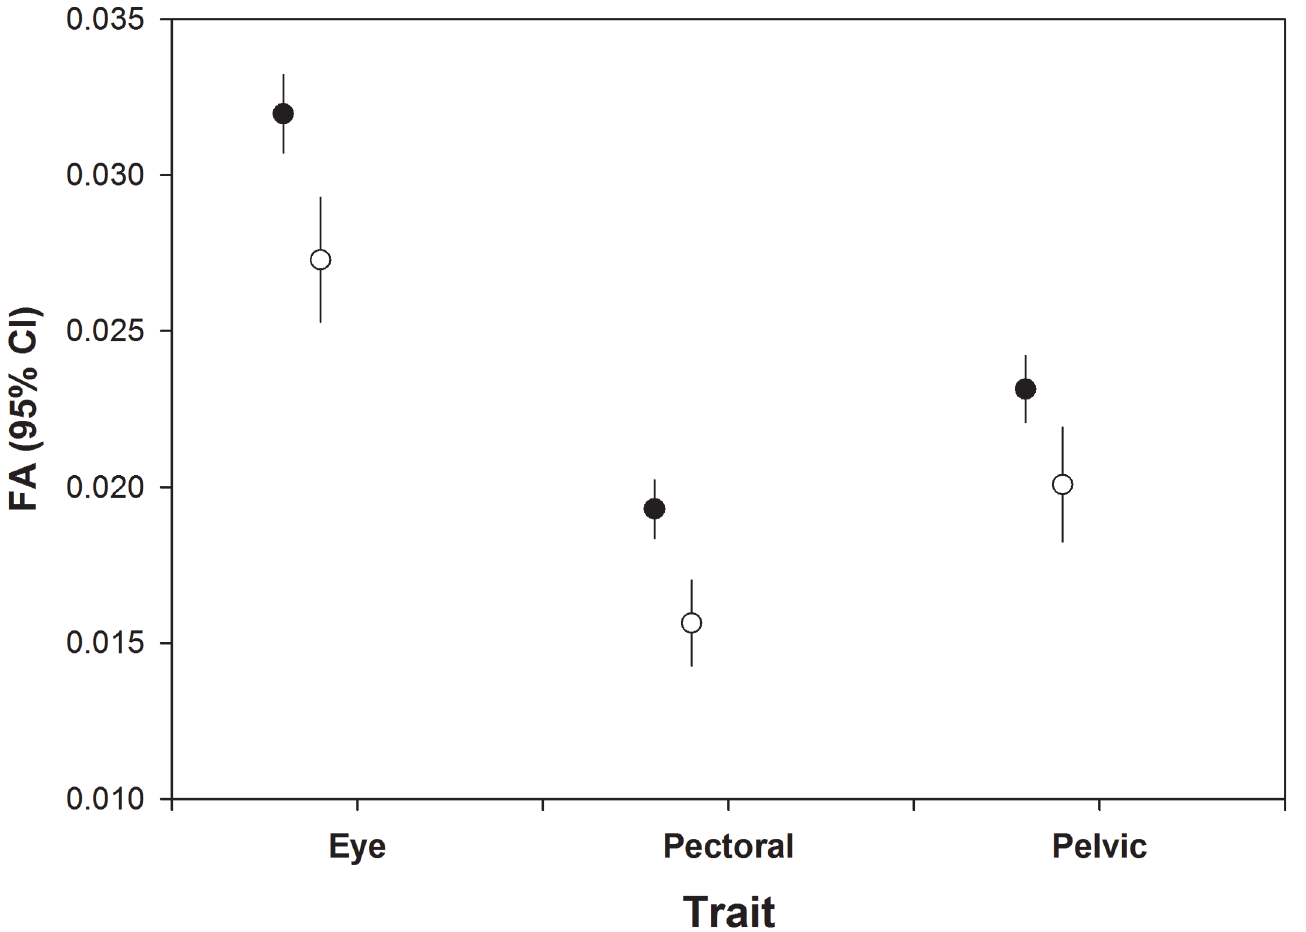
Fig 3. Mean unsigned FA (95% confidence intervals) for each trait by year in post DWH samples, pooling location.